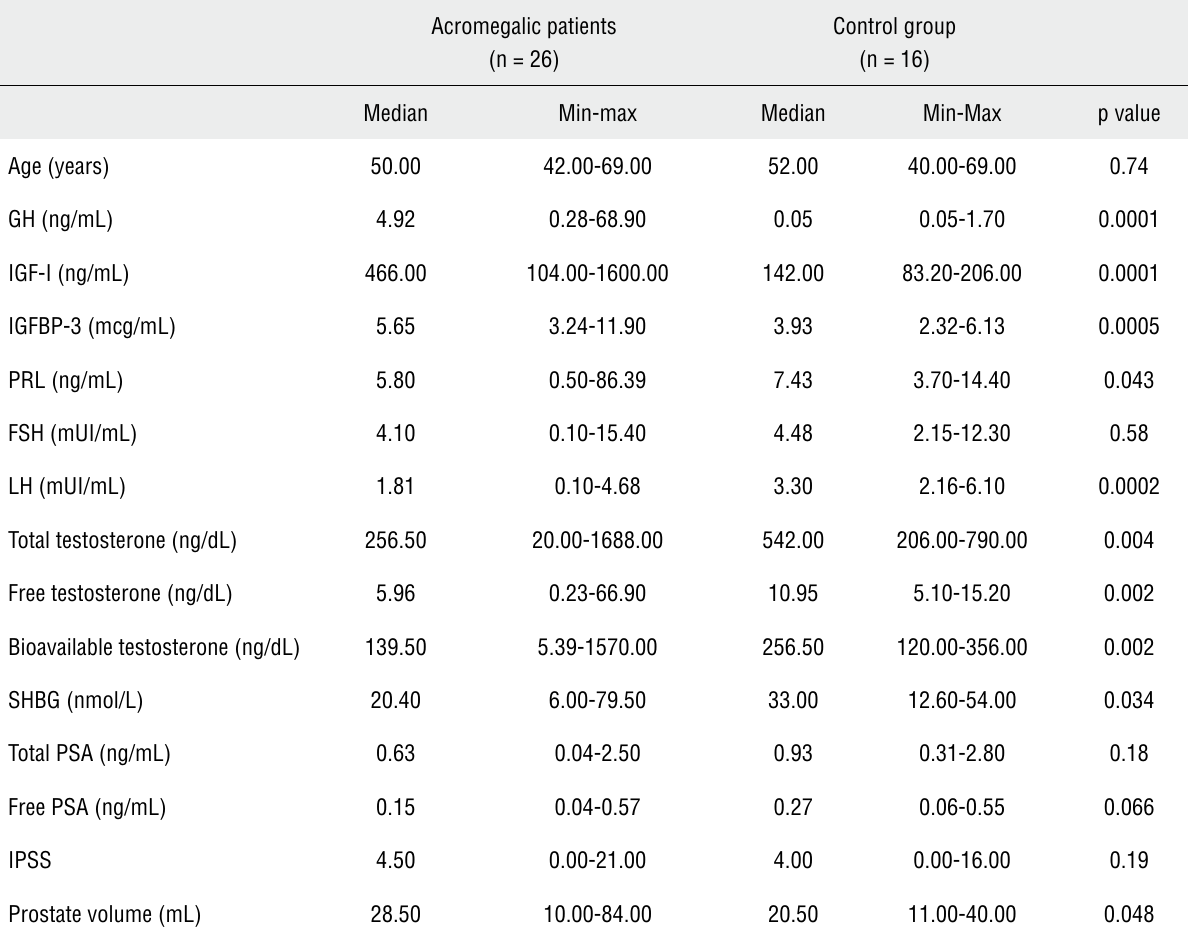
Table 2 - Characteristics of acromegalic patients at baseline and control group ( ≥ 40